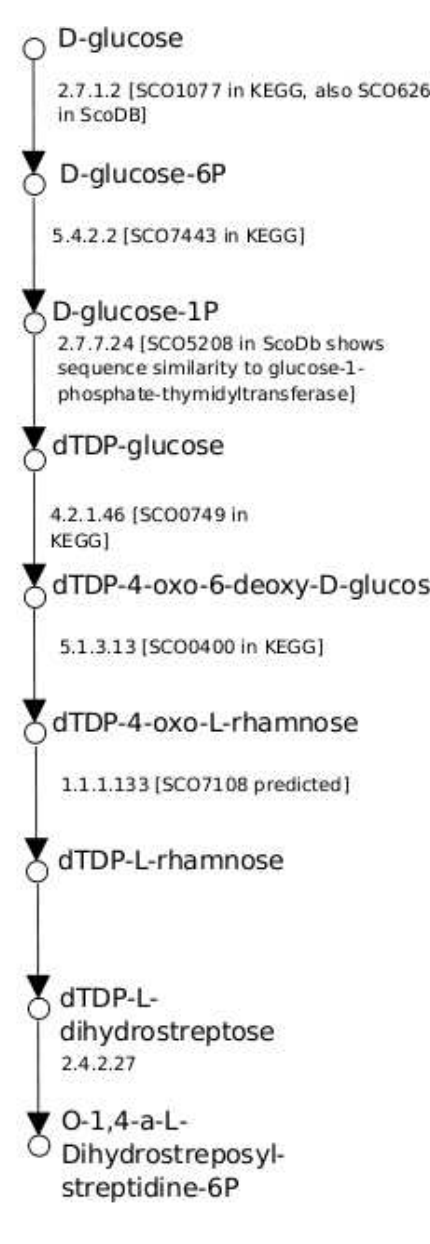
Figure 3: Pathway for